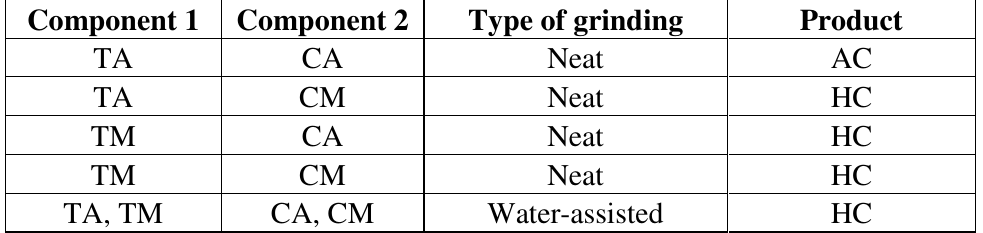
Table 1. Outcome of grinding experiments performed with Theophylline-Citric acid system. The data has been summarized from the work of Jones et al.